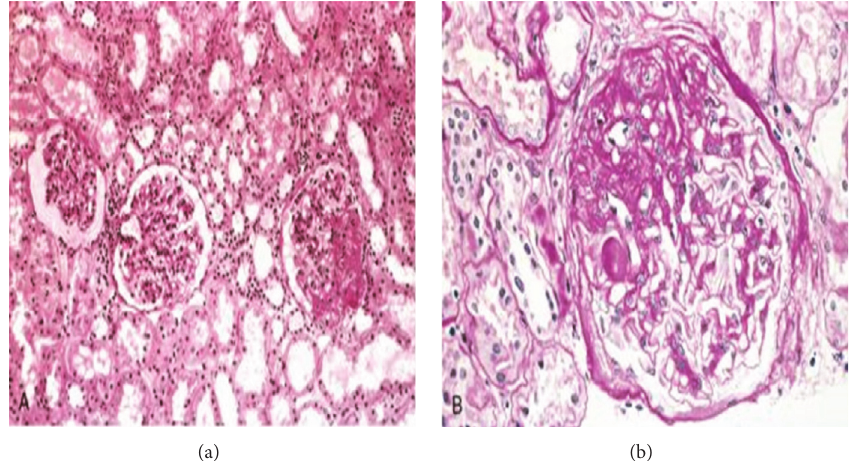
Figure 1: (a) A glomerulus with collapsing FSGS exhibits global wrinkling and retraction of the glomerular basement membranes and diffuse swelling and proliferation of overlying visceral epithelial cells (Jones methenamine silver). (b) In this glomerulus with collapsing FSGS, some of the podocytes are detached from the glomerular basement membrane and lie free within the urinary space (periodic acid Schiff). Magnifications: × 100 in (a) and × 400 in